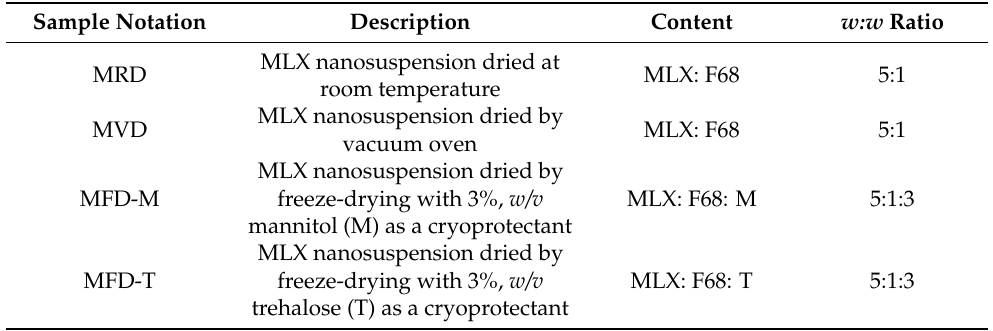
Table 1. Prepared dry nanocrystals alongside their composition and the method of drying. Notation and description of the prepared